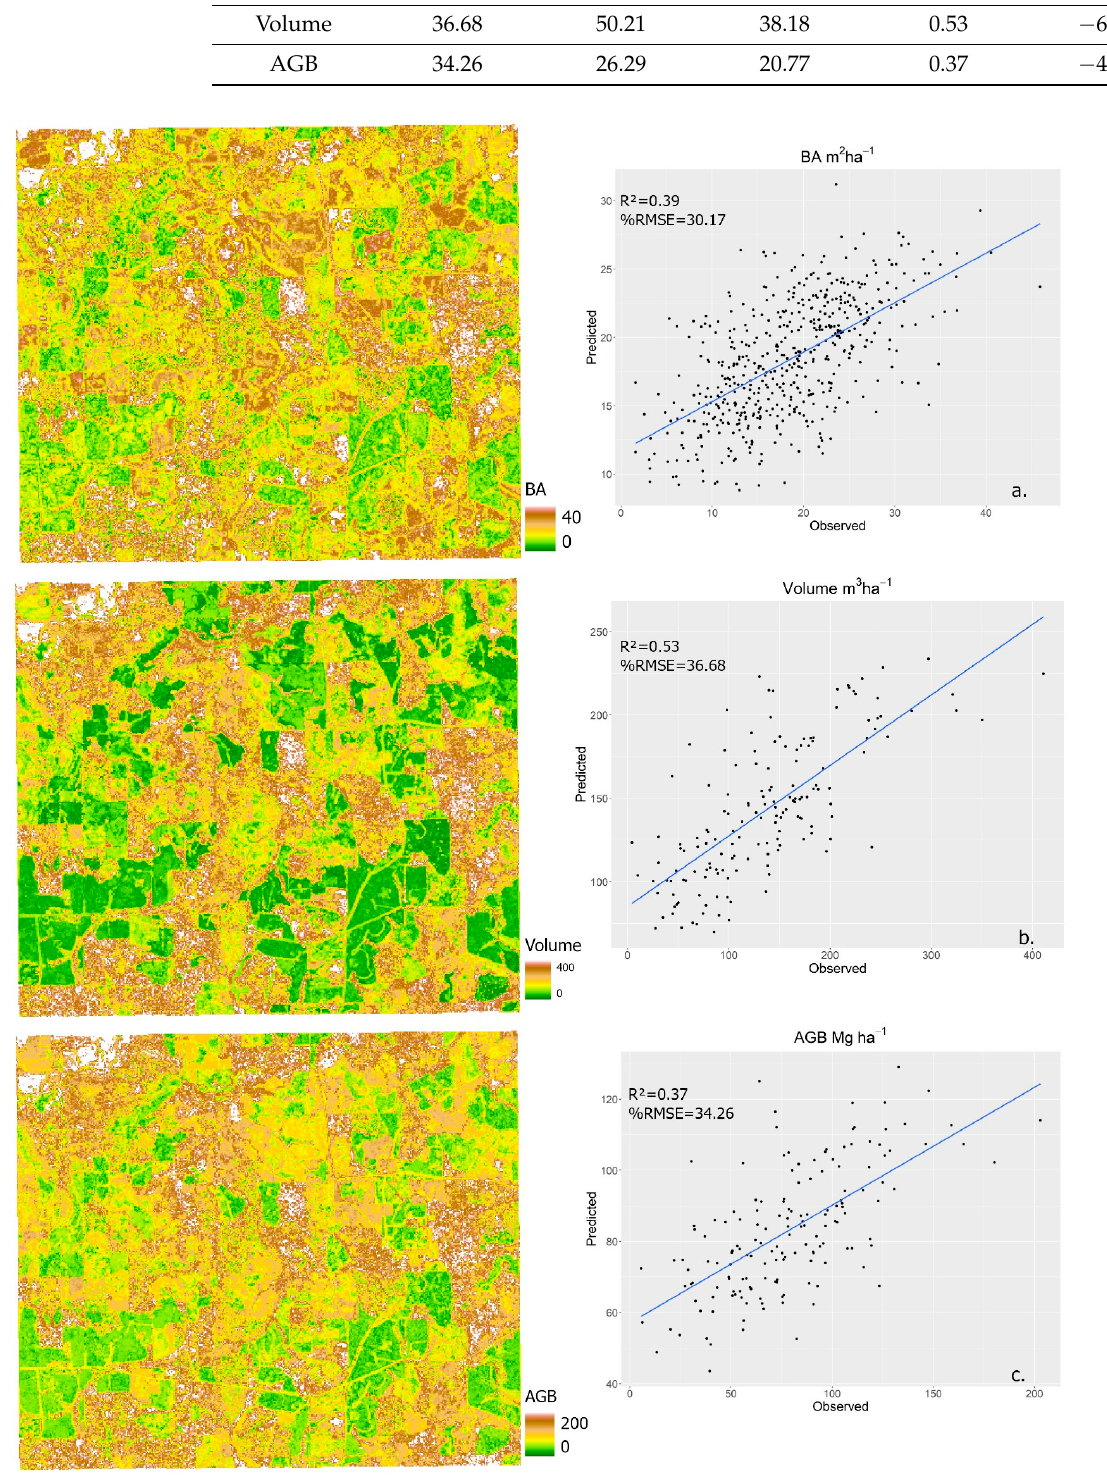
Figure 5. Predicted map outputs of BA ( a ), volume ( b ), and AGB ( c ) with scatterplot displaying correlation between observed and predicted values for the RF models.